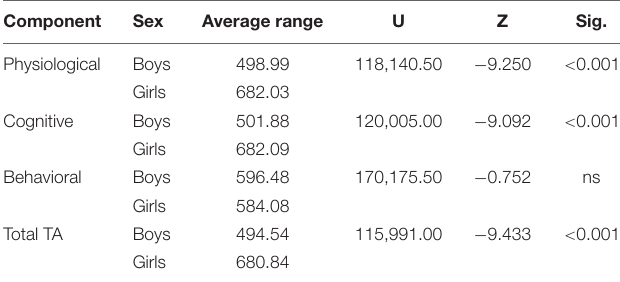
TABLE 2 | Gender difference in test anxiety scores.